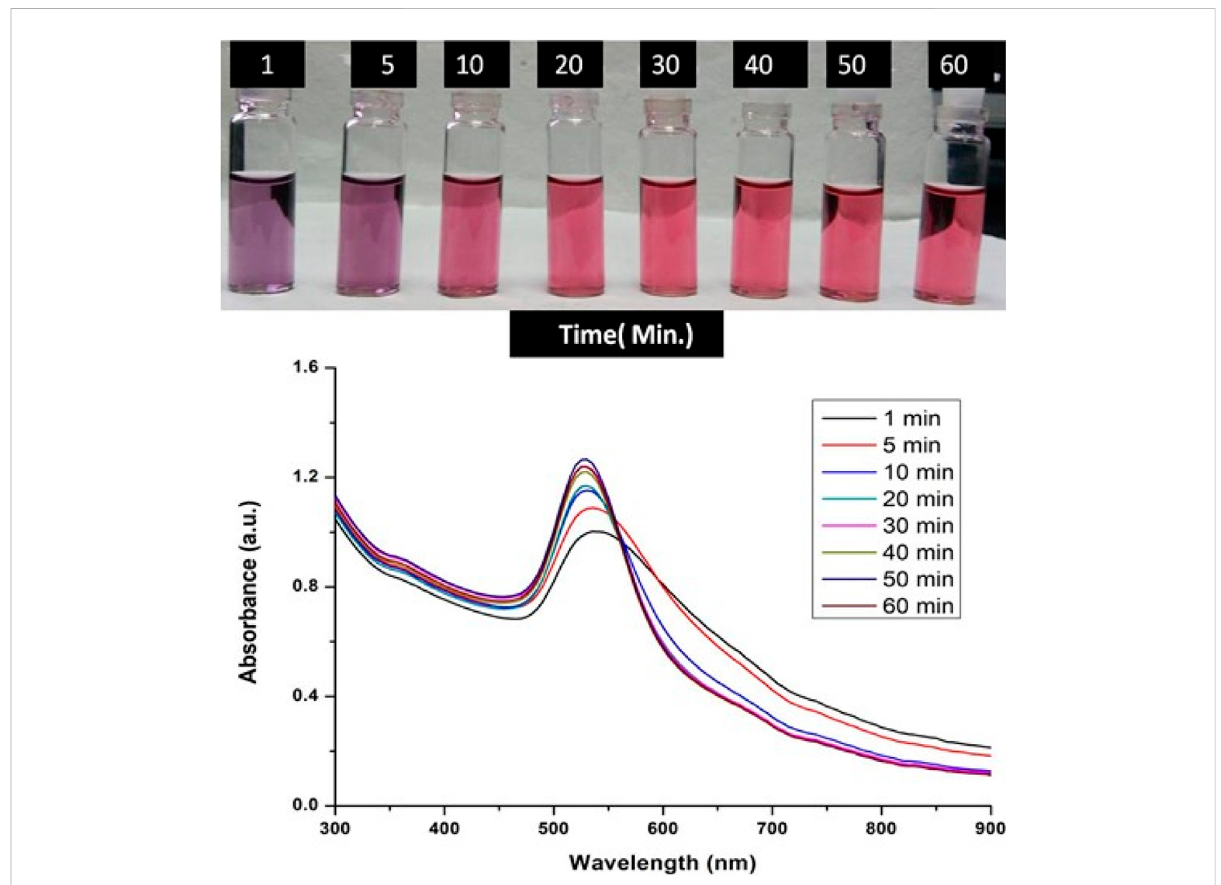
FIGURE 4 UV-VisSpectraofGoldnanoparticlessolutionssynthesisedbyvaryingtimepointsofsynthesisreaction.Theexperimentsweredoneintriplicate and results within each pair differed by < 3.